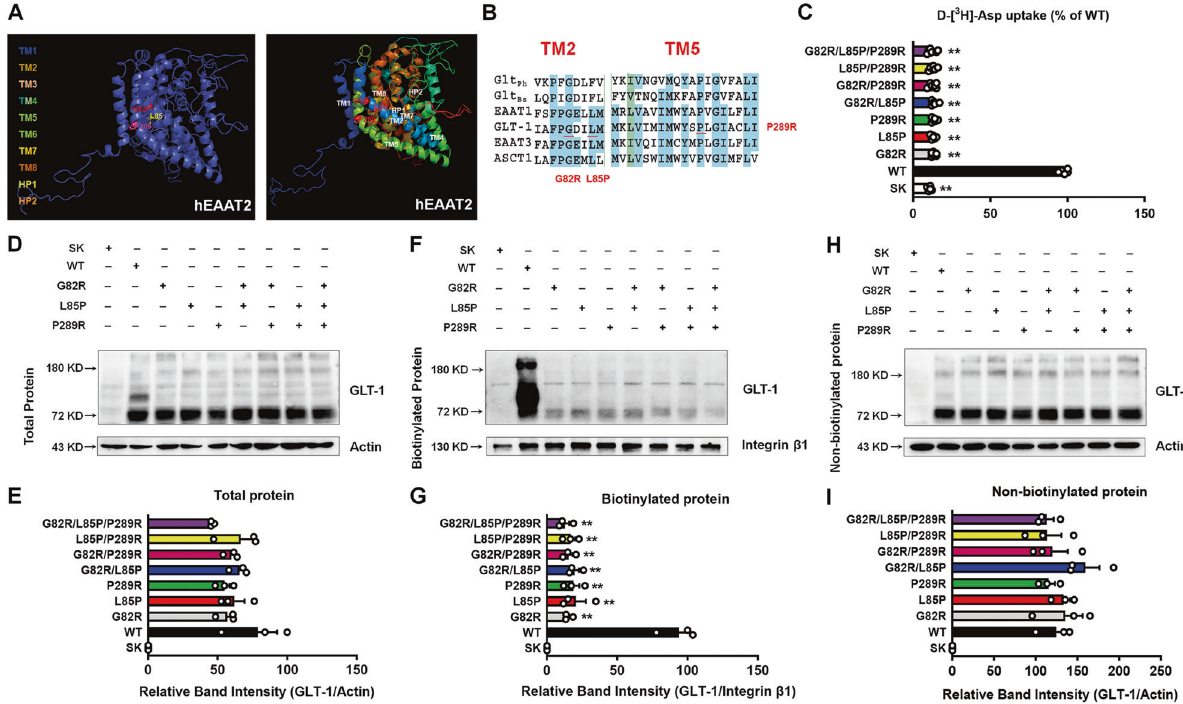
Fig. 1 Epileptic variants decrease the expression and function of GLT-1. A Topological location of Gly-82, Leu-85, and Pro-289 residues in human EAAT2. B Comparison of the amino acid sequences of epileptic variants (G82R, L85P, and P289R) between Glt ph and EAATs. Regions of high homology of Glt Ph and EAATs are highlighted in blue. C D-[ 3 H]-Asp uptake activity after transfection with different plasmids (SK, WT, G82R, L85P, P289R, G82R/L85P, G82R/P289R, L85P/P289R, and G82R/L85P/P289R) were determined. n = 6 per group. The representative blots and quanti fi cation of total proteins ( D , E ), biotinylated membrane proteins ( F , G ), and non-biotinylated proteins ( H , I ) of GLT-1 were measured by Western blot. n = 3 per group. Results are expressed as mean ± SD. ** P < 0.01 vs. WT. Statistical signi fi cance was determined using one-way ANOVA and Tukey ’ s test for post hoc